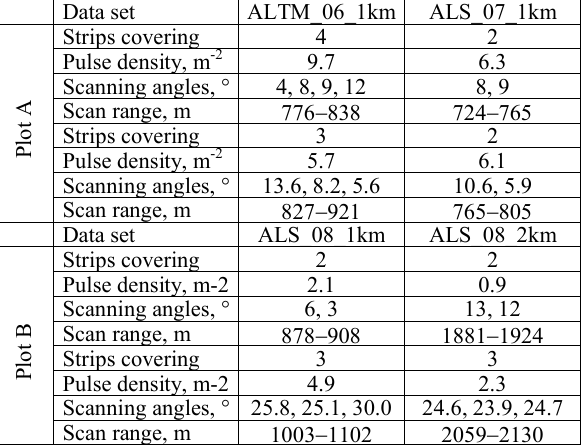
Table 3. Characteristics of the LiDAR data sets per the plot.